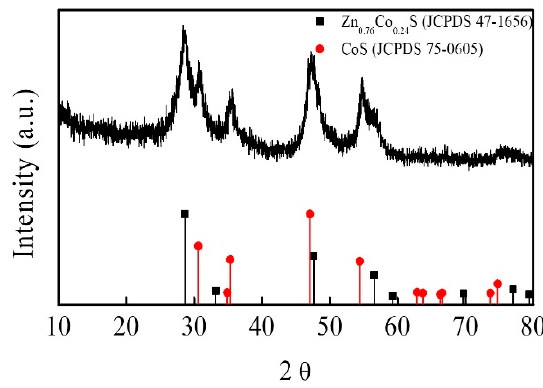
Figure 2. XRD patterns of Zn-Co-S BHS.